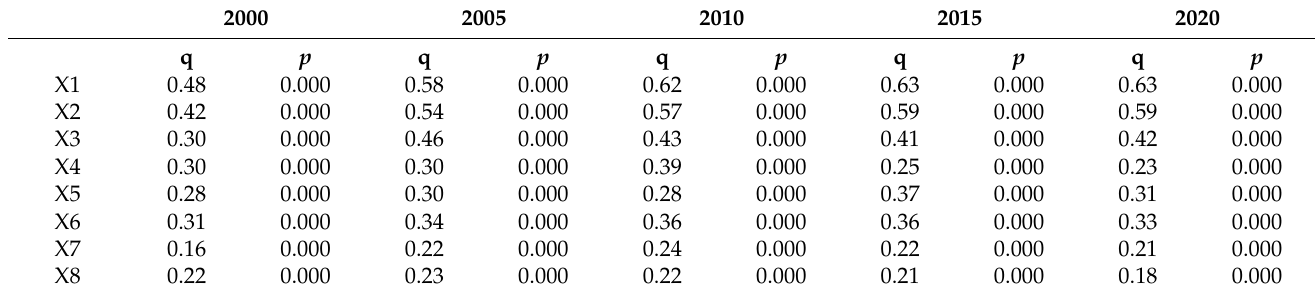
Table 5. Explanatory power of the factors with respect to the RSEI detection for